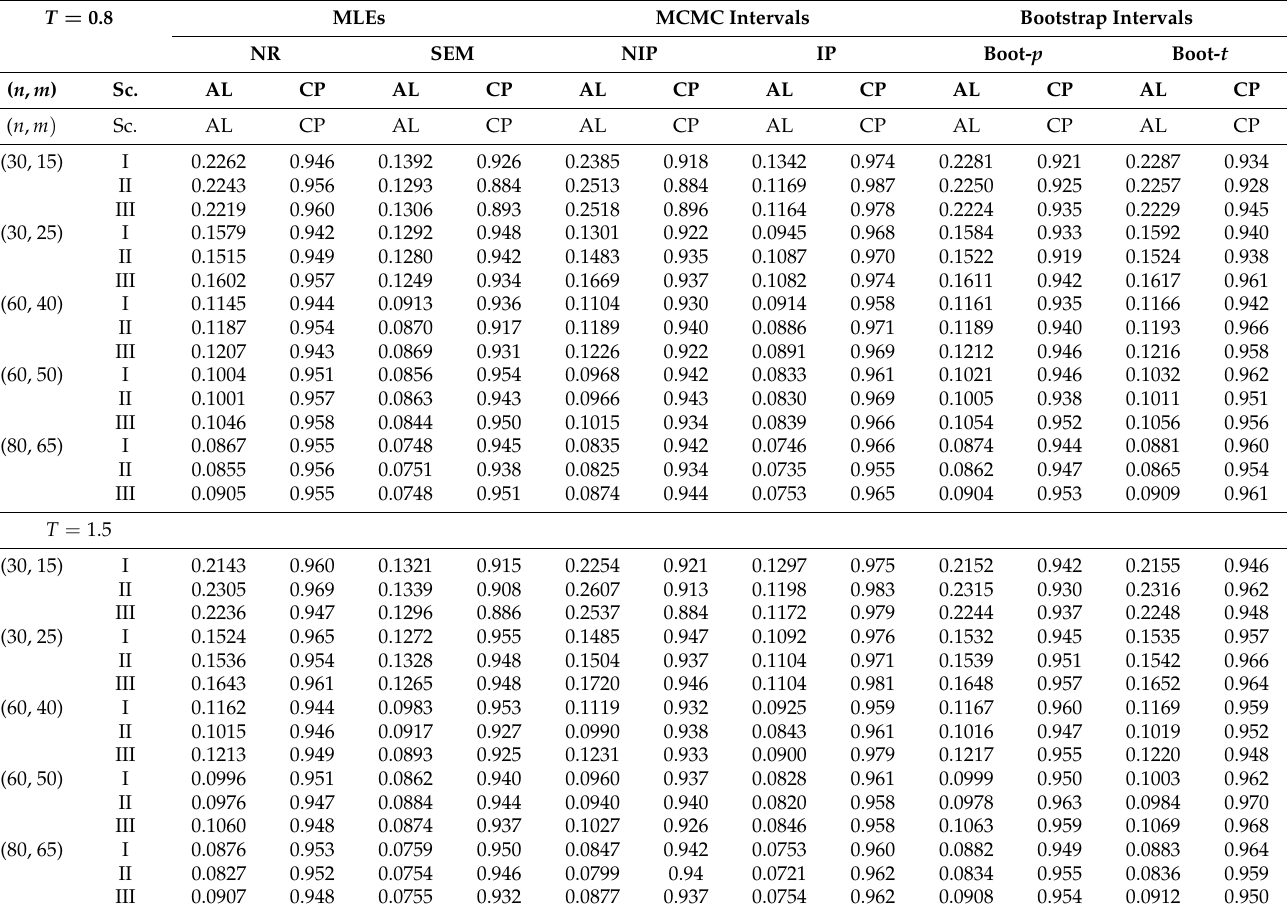
Table 13. 95% CI’s, average length (AL) and coverage percentage (CP) of approximate, Bayes and bootstrap confidence intervals of θ 2 under informative prior (IP) and noninformative (NIP) prior, for different schemes with different values of n and m, when ( θ 1 , θ 2 , λ ) = (0.05, 0.06, 1.8).